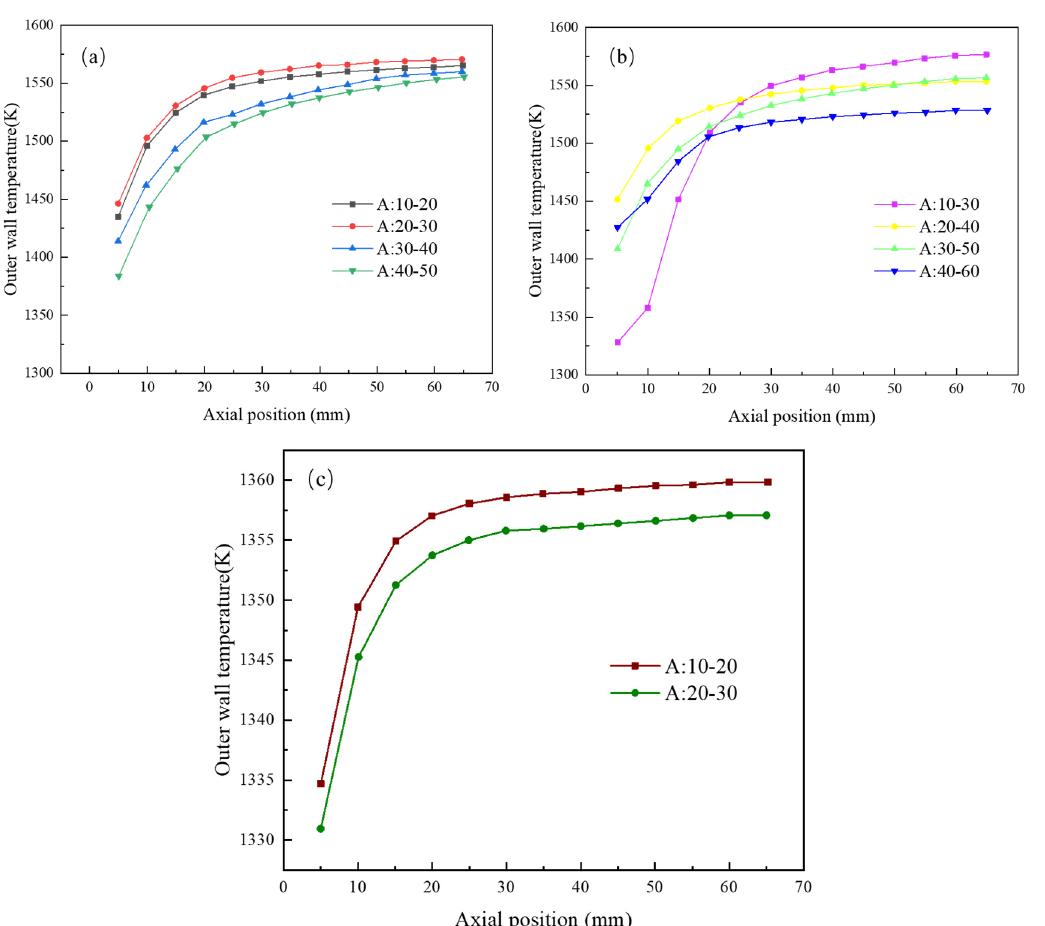
Figure 12. Outer wall temperature ( a ) Δ n = 10 PPI, ( b ) Δ n = 20 PPI, ( c ) Δ n = 30 PPI.